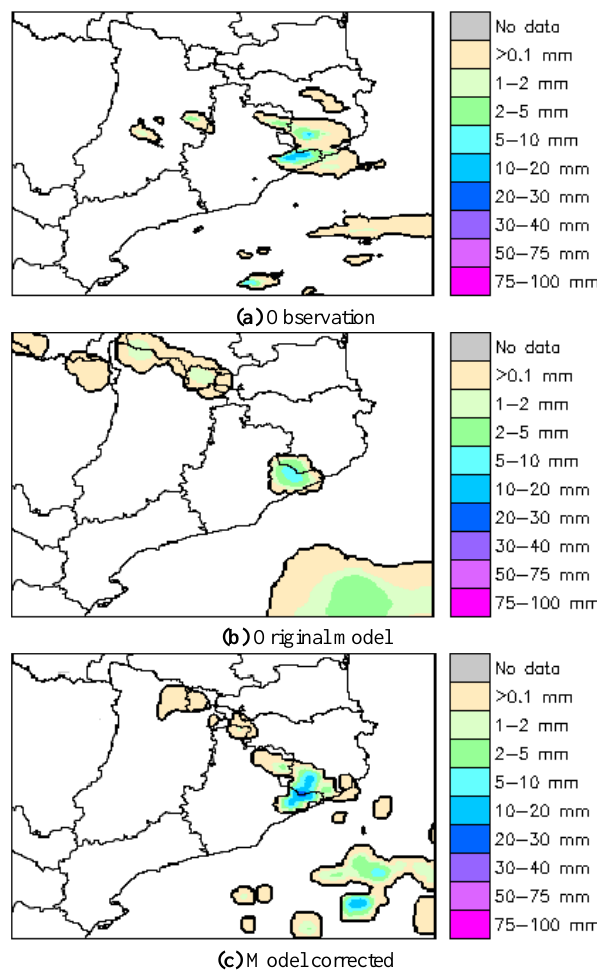
Fig. 3. Example of the model correction procedure for the period 13:00–14:00UTC ( t +1h) of 3 October 2008